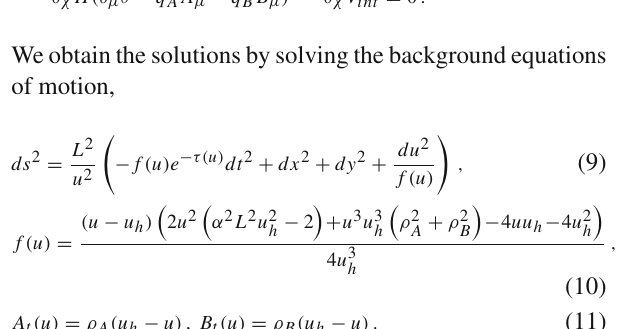
metry. The complex scalar field represents the order parame- terforsuperconductingphasetransition. x = ρ B /ρ A iscalled as dope parameter. u denotes holographic coordinate